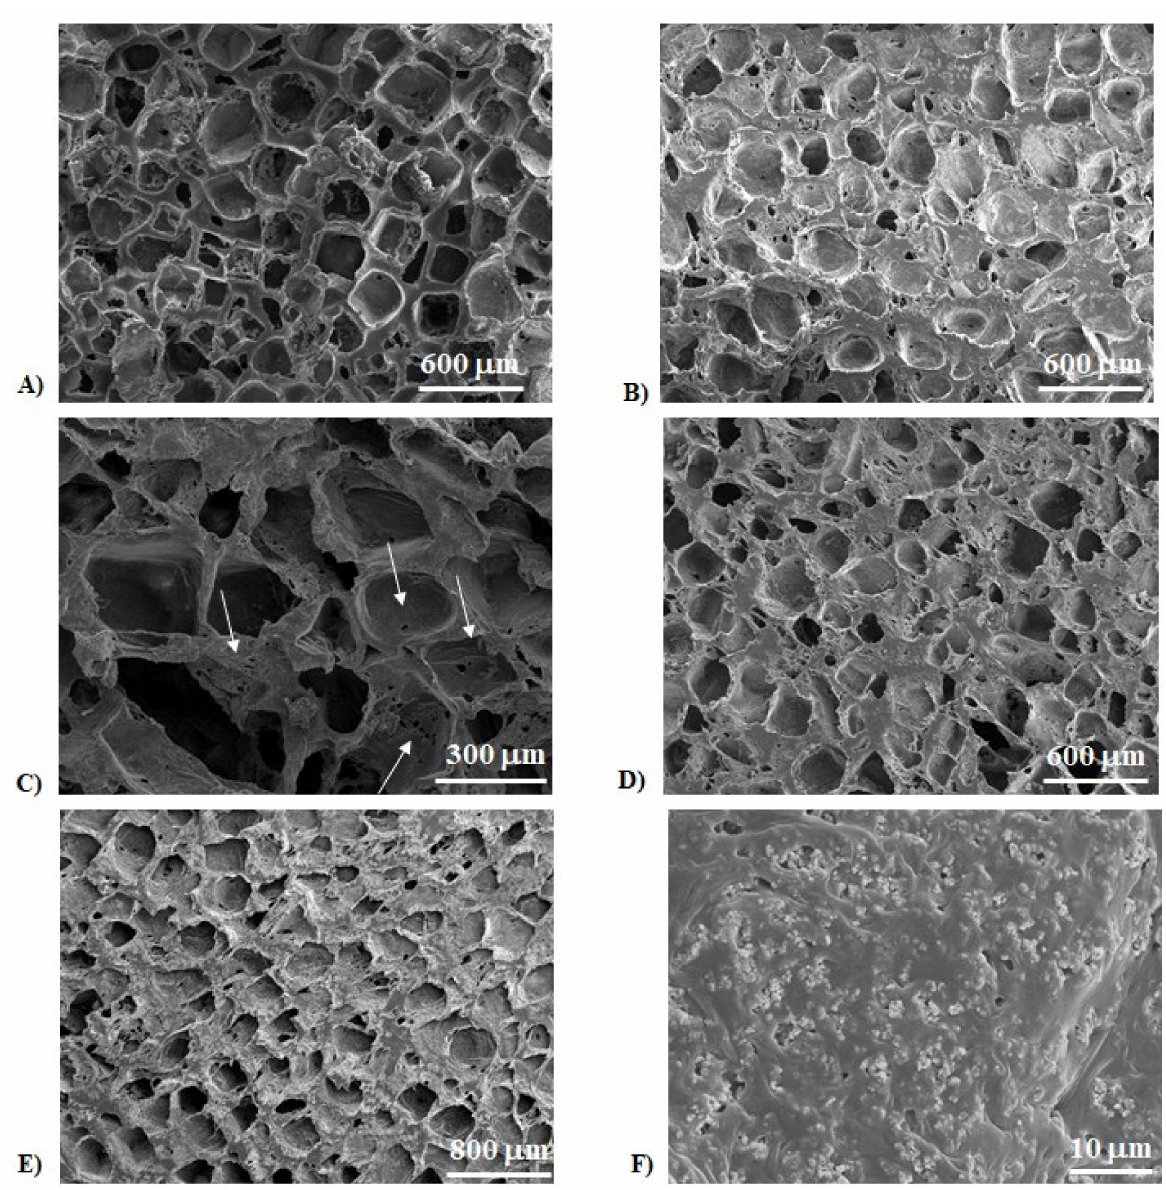
Figure 1. Field emission scanning electron microscopy (FESEM) micrographs of poly( ε -caprolactone) (PCL) scaffolds obtained by using sodium chloride, NaCl ( A ) and sodium nitrate, NaNO 3 ( B ) salts as templates (analysis carried out on the material sections); ( C ) higher magnification FESEM micrograph of a sample obtained by using NaCl, showing microporosities within the struts, and on the pore walls; ( D ) micrograph of PCL + silver (Ag), showing the same morphology of the neat polymer scaffold; ( E ) lower and ( F ) higher magnification micrographs of a biphasic calcium phosphate (BCP)/PCL sample showing the fine and homogeneous distribution of the calcium phosphate particles inside the polymer